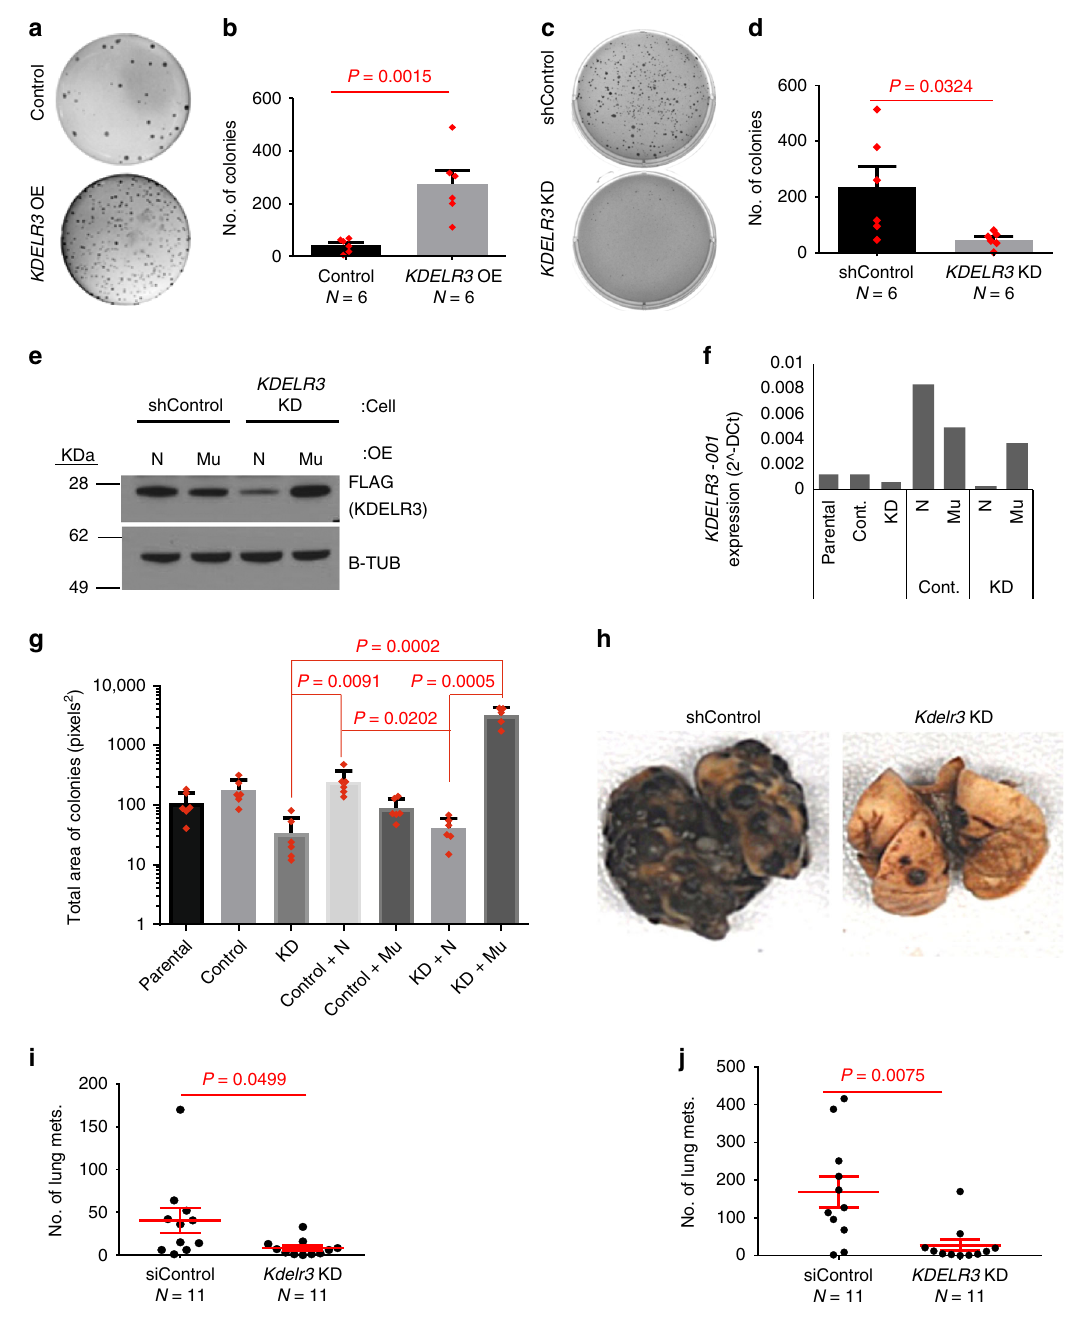
Fig. 3 KDELR3 mediates melanoma metastatic potential. a – d Soft agar colony formation assay with a , b overexpression of KDELR3 ( KDELR3 OE) in human SK-MEL-28 cells vs. parental cell, unpaired two-tailed Student ’ s t test, P = 0.0015, d.f. = 10, t = 4.307. Six wells were analyzed per group. N = 6 (Control) and N = 6 (KDELR3 OE). c , d shRNA KDELR3 knockdown ( KDELR3 KD) in human WM-46 cells vs. non-targeting control, unpaired two-tailed Student ’ s t test, P = 0.0324, d.f. = 10, t = 2.483. N = 6 wells analyzed per group. e , f Western blot and qPCR analysis of exogenously expressed FLAG-tagged KDELR3- 001 ; ENST00000216014 (N) and KDELR3-001 Mu (Mu) in WM-46 ( e ) and 1205Lu ( f ) cells, transduced with non-targeting control (shControl/Cont./ Control) or KDELR3 -targeted (KD) shRNAs. Total KDELR3-001 RNA ( KDELR3-001 and KDELR3-001 Mu ) ( f ). g Rescue of soft agar colony formation in KDELR3- 001 Mu cells (WM-46), Kruskal – Wallis with Dunn ’ s multiple comparison test. Five to six wells were analyzed per group. h , i Tail vein metastasis of Kdelr3 siRNA knockdown ( Kdelr3 KD) in mouse B16 cells. Unpaired two-tailed Student ’ s t test with Welch ’ s correction, P = 0.0499, d.f. = 10.83, t = 2.207. N = 11 (siControl) and N = 11 ( Kdelr3 KD). j Tail vein metastasis of KDELR3 siRNA-mediated knockdown in human 1205Lu cells transduced with Ferh-luc-GFP . Unpaired two-tailed Student ’ s t test with Welch ’ s correction, P = 0.0075, d.f. = 12.57, t = 3. N = 11 (siControl) and N = 11 ( KDELR3 KD). b , d Bars and error bars depict mean ± s.e.m. g Bars and error bars depict mean ± SD. i , j Lines and error bars depict mean ± s.e.m. a – f , h – j Representative of three independent experiments. g Representative of two independent experiments. e β -tubulin loading